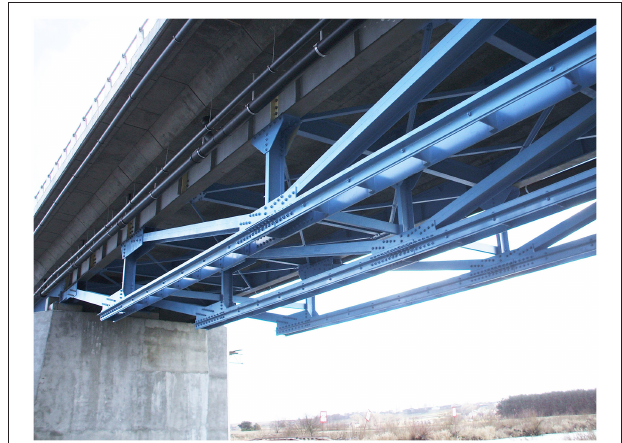
FIGURE 4 | Bottom view of the extreme span–visible details of the added structure during the renovation; from Olaszek (2015) permission was granted by The Committee on Civil Engineering and Hydroengineering of the Polish Academy of Sciences.